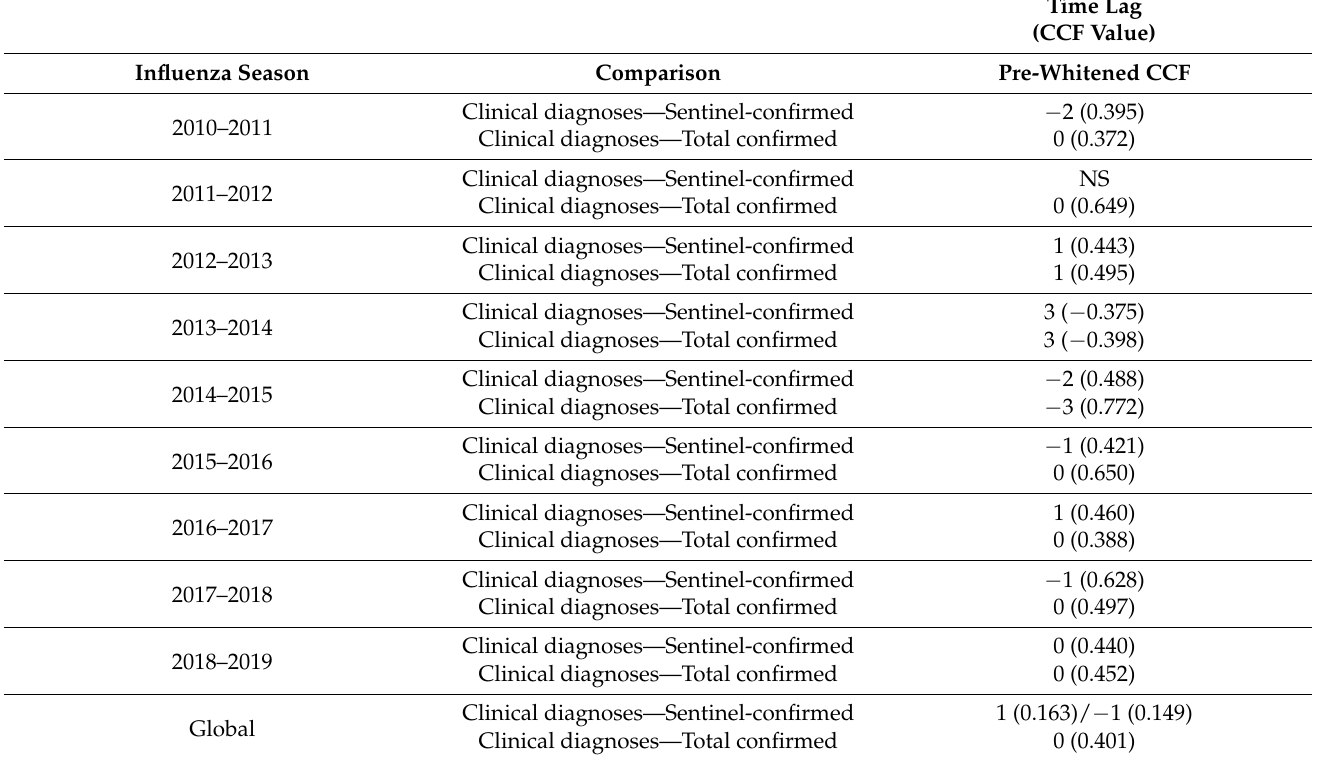
Table 3. Cross-correlation function